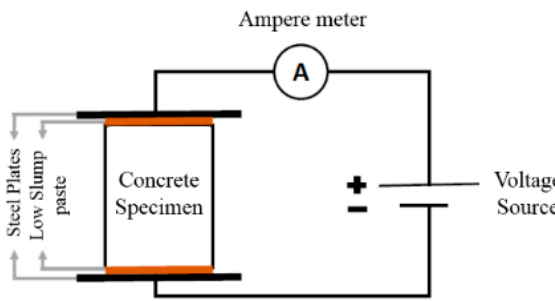
Figure 5. Schematic view of the circuit of the ER test.